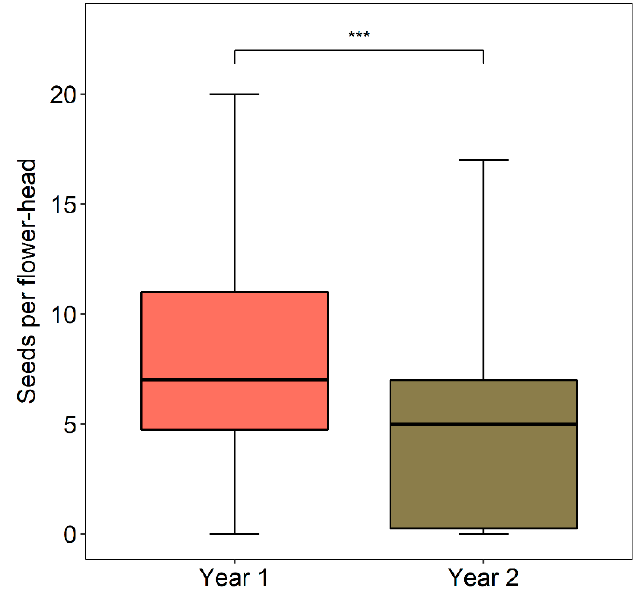
Figure 9. Seed set per flower-head in M. subulata over the last two years of the Chilean mega drought. Yr-1 is the austral summer of 2018–2019; Yr-2 is the austral summer of 2019–2020. Retrieved flower-head sample sizes were N = 132 (Yr-1), N = 66 (Yr-2). The three asterisks (***) indicate a significant difference between years ( p < 0.001) based on the Mann–Whitney U-test.